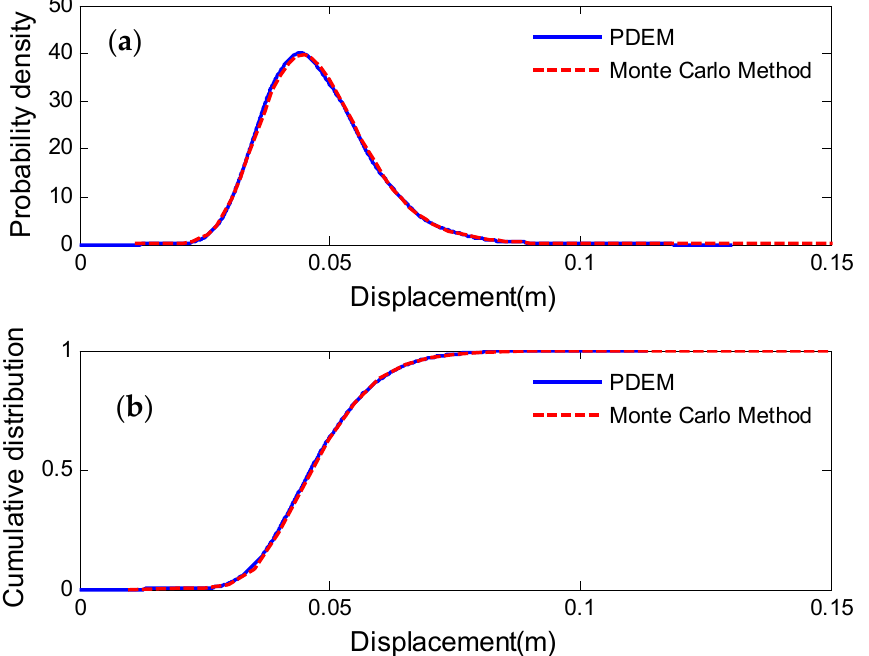
Figure 2. ( a ) Probability density function (PDF) of horizontal displacement of pile top. ( b ) Cumulative distribution function (CDF; i.e., reliability) of horizontal displacement of pile top.